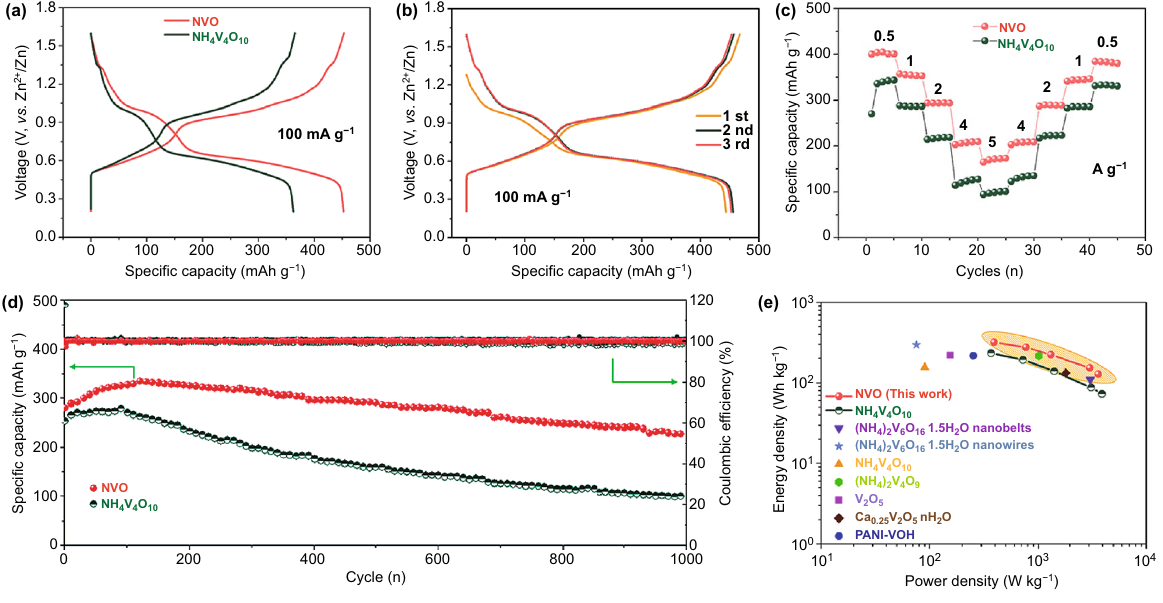
Fig. 4 Electrochemical performance of NVO and NH 4 V 4 O 10 . a Comparison of GCD plots at 100 mA g −1 . b GCD curves of NVO in first three cycles. c Rate performance of NVO and NH 4 V 4 O 10 . d Cycling stability with the corresponding coulombic efficiencies at 2 A g −1 . e Ragone plots in comparison with other cathodes, such as (NH 4 ) 2 V 6 O 16 ·1.5H 2 O nanobelts [48], (NH 4 ) 2 V 6 O 16 ·1.5H 2 O nanowires [32], NH 4 V 4 O 10 [50], (NH 4 ) 2 V 4 O 9 [51], V 2 O 5 [73], Ca 0.25 V 2 O 5 ·nH 2 O [74], PANI-VOH